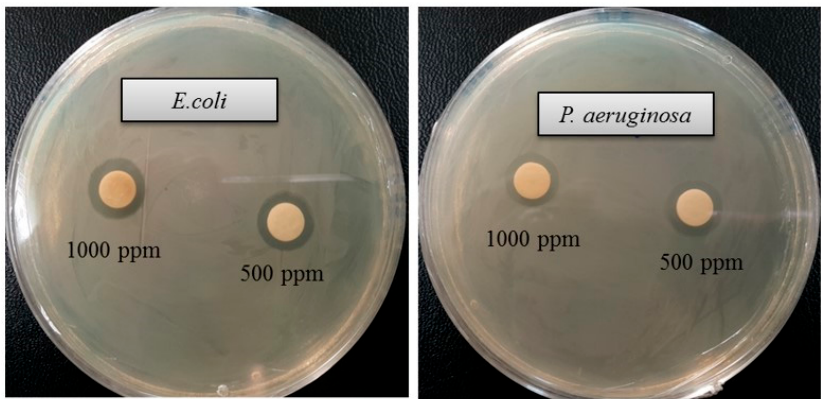
Figure 7. Zones of inhibition of ecofriendly synthesized AgNPs (30 µ L) at 500 and 1000 ppm concentrations in water against E. coli and P. aeruginosa. Table 4. Antimicrobial activity of eco-friendly synthesized AgNPs against E. coli and P. aeruginosa .